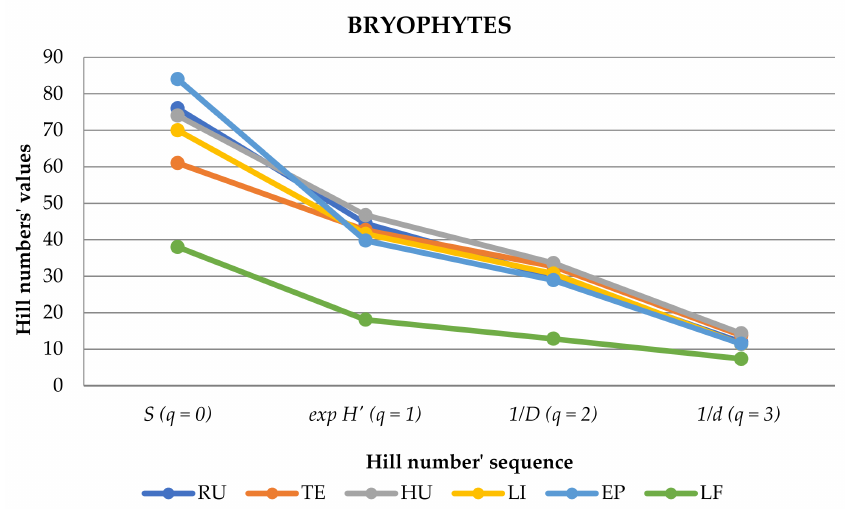
Figure 5. Diversity (Hill numbers) profile for the different elevational bands in the Pico Island transect (RU = rupicolous; TE = terricolous; HU = humicolous; LI = lignicolous; EP = epiphytic; and LF =